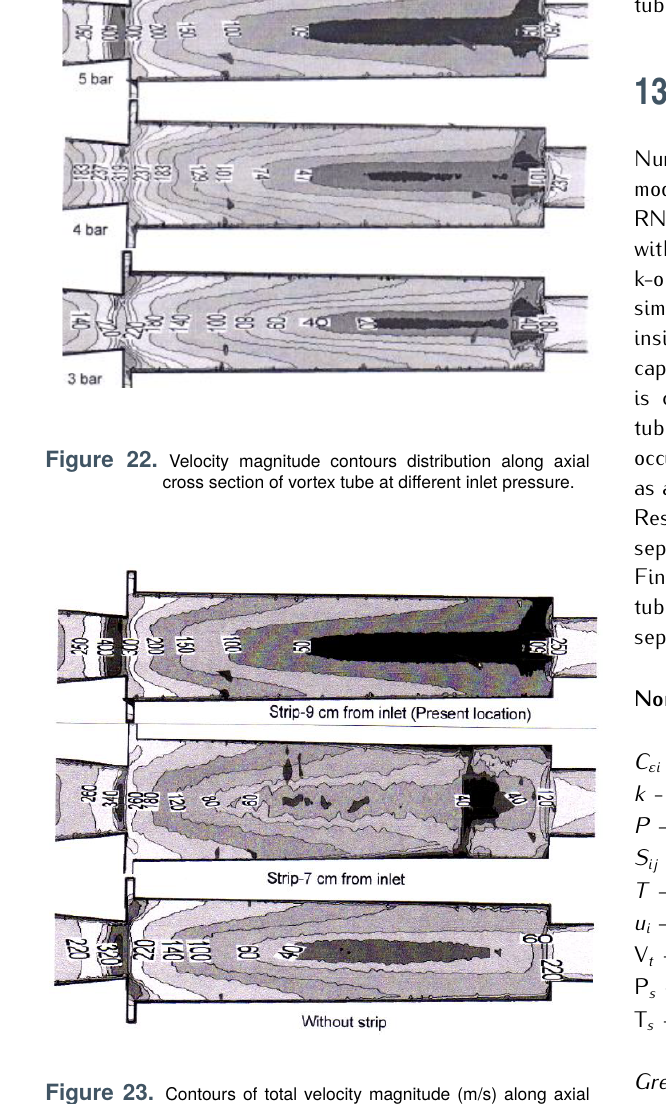
tube performance without the wall-mounted strip as